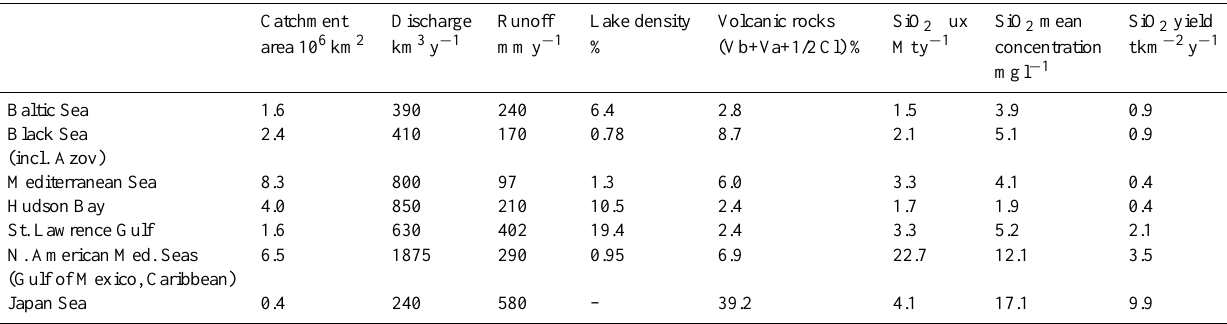
Table 6. Dissolved silica fluxes, concentration and yield for selected regional sea catchments: North Atlantic Regional Seas and Japan Sea. Catchment surface area, discharge and runoff are given from Meybeck et al. (2007) as well as % of volcanic rocks from D¨urr et al. (2005) and lake density from Lehner and D¨oll